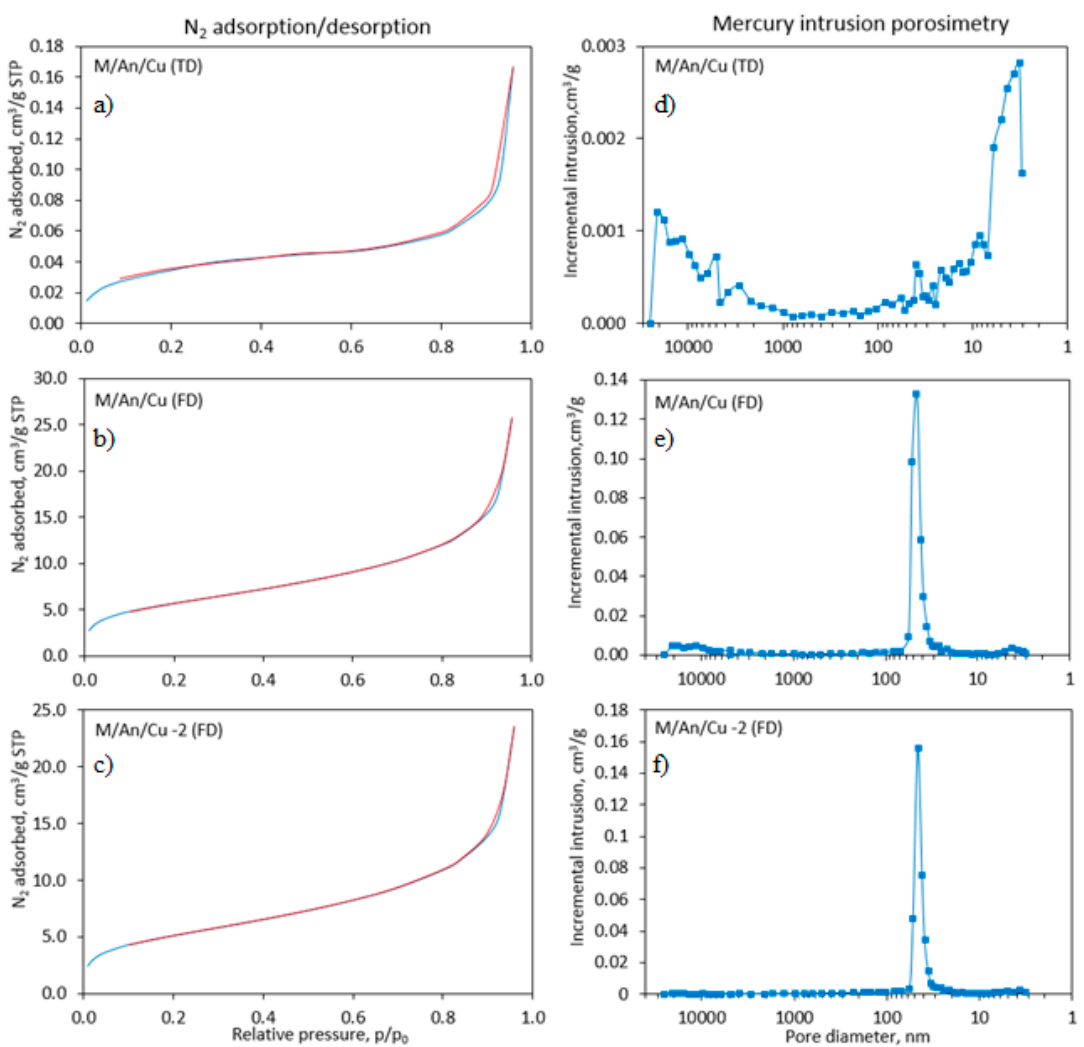
Figure 5. Isotherms of N 2 adsorption/desorption ( a ), ( b ), ( c ) and pore size distribution determined by mercury intrusion porosimetry ( d ), ( e ), ( f ) for thermally dried M/An/Cu ( a ), ( d ) freeze-dried M/An/Cu ( b ), ( e ) and freeze-dried M/An/Cu-2 obtained by method-2. Table 5. Porous characteristics of supporting anion exchanger and Cu 0 -doped anion exchanger (additional sample specification FD means freeze-dried samples).